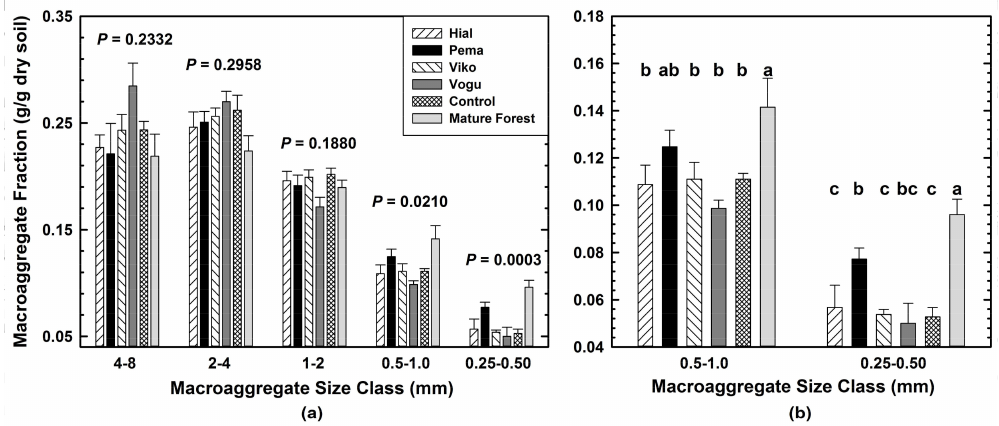
Figure 1. Effect of vegetation type on macroaggregate size distributions. ( a ) All size classes; ( b ) Detail of smaller size classes with significant differences denoted by letters.